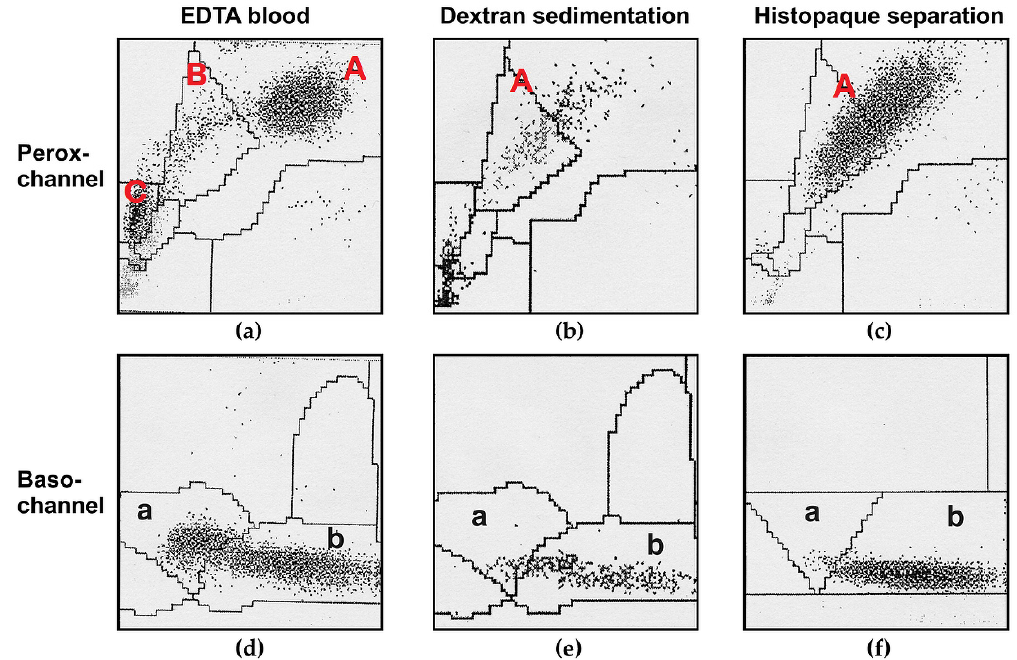
Figure 1. Presentation of blood cells on the ADVIA-120 blood cell counter before and after preparation of leukocytes via dextran or Histopaque separation. ( a – c ) Perox-channel: x -axis, myeloperoxidase (MPO) activity; y -axis, side scatter. ( d – f ) Baso-channel: x -axis, chromatin density (high angle signal 5–15°); y -axis, cell volume (low angle signal). ( a , d ) Normal cell distribution in whole blood measured in the perox-channel (A: neutrophil granulocytes, B: monocytes, C: lymphocytes; the small number of eosinophilic granulocytes are located in the area below A) and in the baso-channel (a: lymphocytes and monocytes, b: neutrophilic and eosinophilic granulocytes). ( b , e ) Distribution of cell populations after dextran sedimentation. The neutrophil granulocyte population in the perox-channel shifted partly into the monocyte gate due to MPO release, whereas the population of granulocytes (neutrophilic and eosinophilic granulocytes) was unchanged in the baso-channel (measuring nucleus characteristics). ( c , f ) Distribution of separated granulocyte fraction after Histopaque isolation ( > 96% purity). The granulocyte fraction in the perox-channel showed a shift into the monocyte gate similar to that after dextran sedimentation. The population in the baso-channel was not influenced.